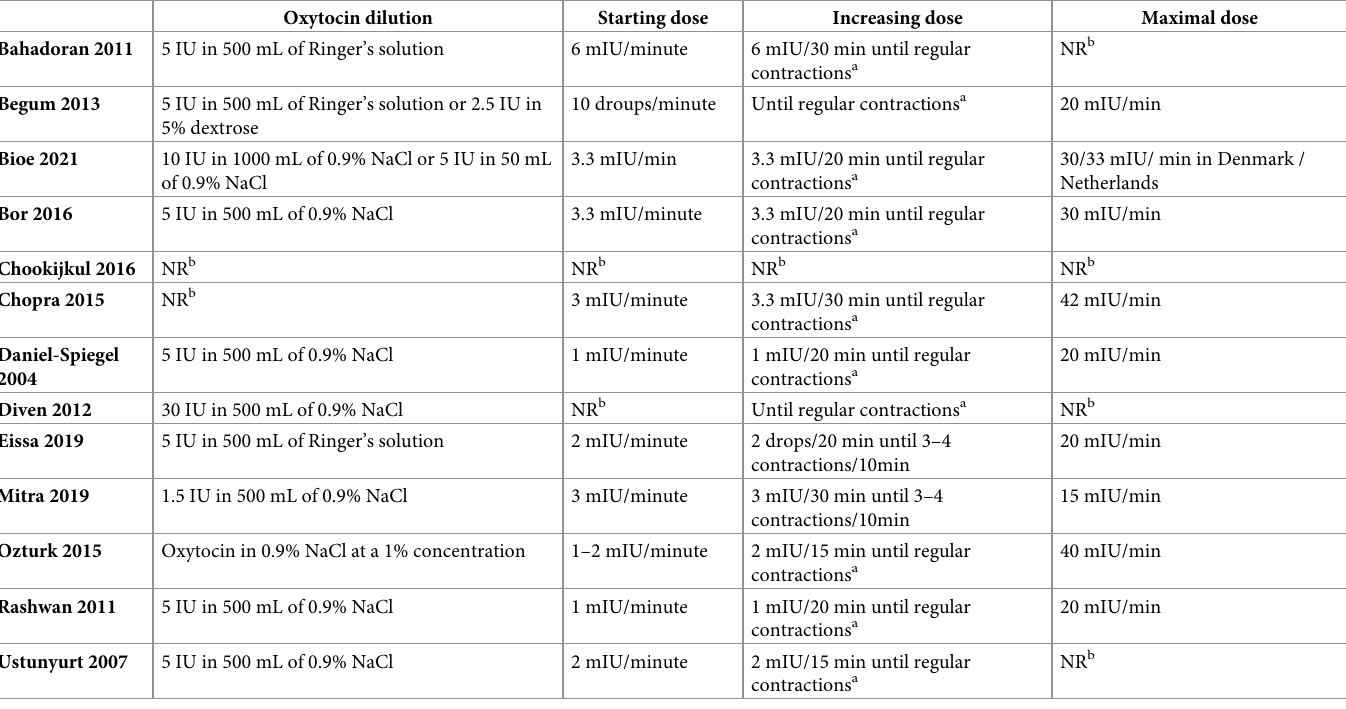
Table 2. Detailed oxytocin protocol in each